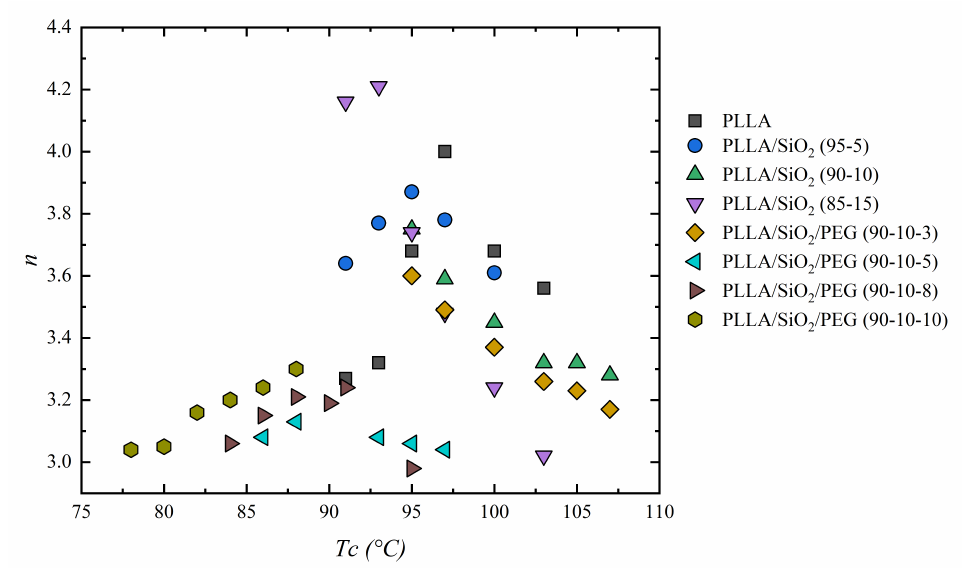
Figure 7. Avrami index (n) as a function of isothermal crystallization temperature (T c